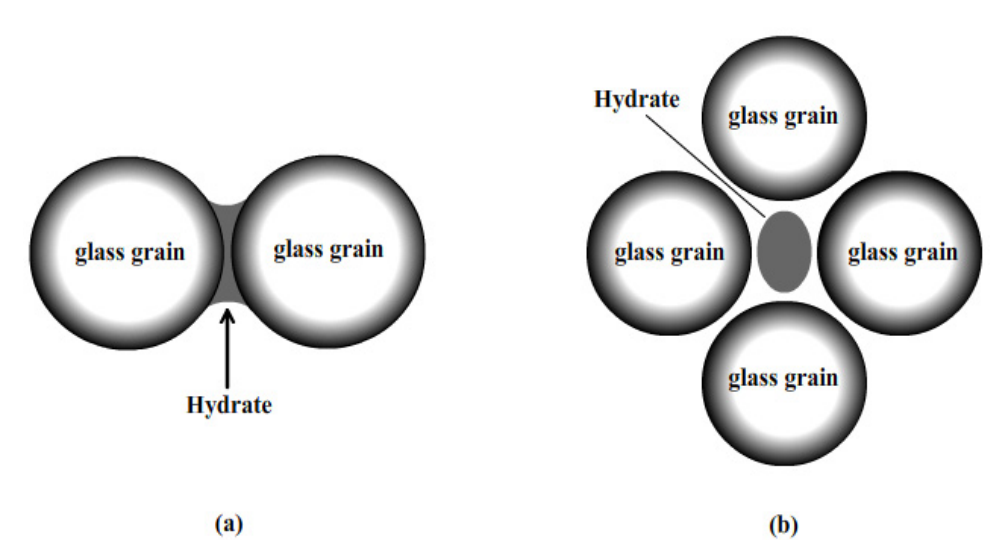
Figure 3. The microstructure of hydrates in sediments. ( a ) The cementing model; ( b ) The free flowing model.